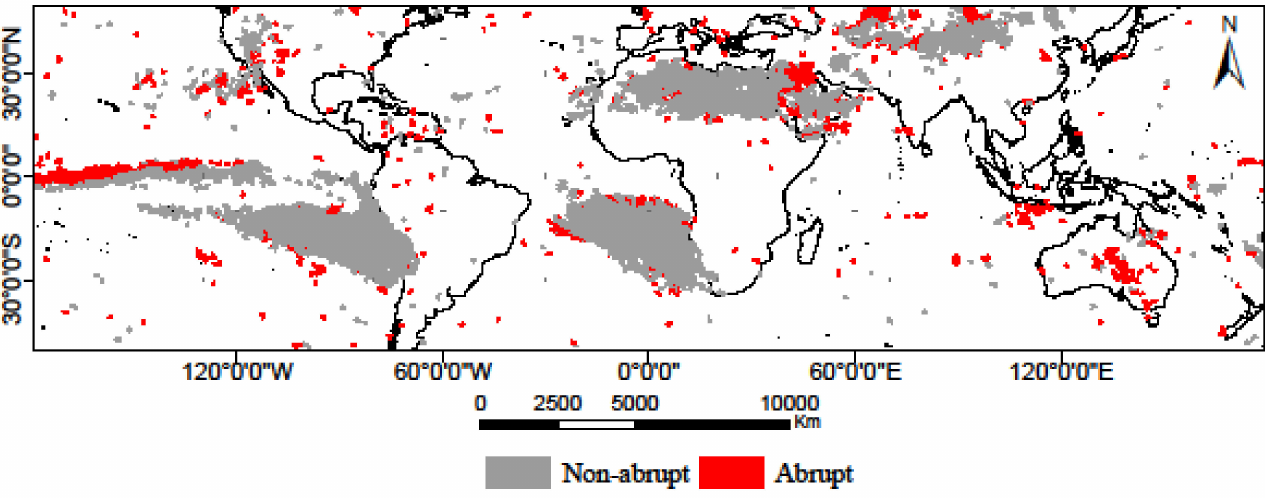
Figure 3. Abrupt and non-abrupt changes in the global precipitation time series, 1998–2019.